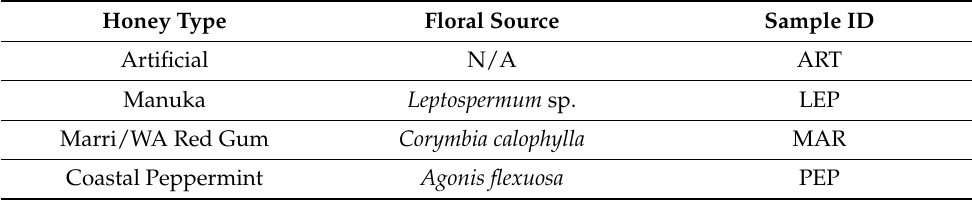
Table 6. Honey samples, including packaging information and sample